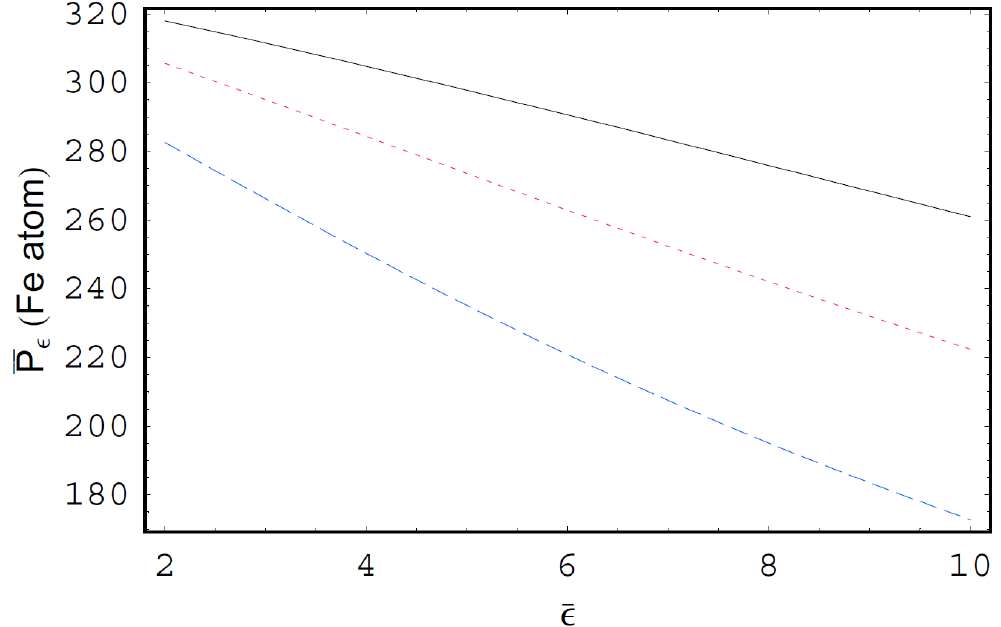
cn e n a ] as a function of [ (32 / 3 ) ] P r cn n π= as a 0 e a 0 0 ε 15 E = without the Coulomb [ (32 / 3 ) ] P r cn n π= as a for the Fe atom when 0 e a 0 0 ε 15 E = without the Coulomb for the Fe atom when 0